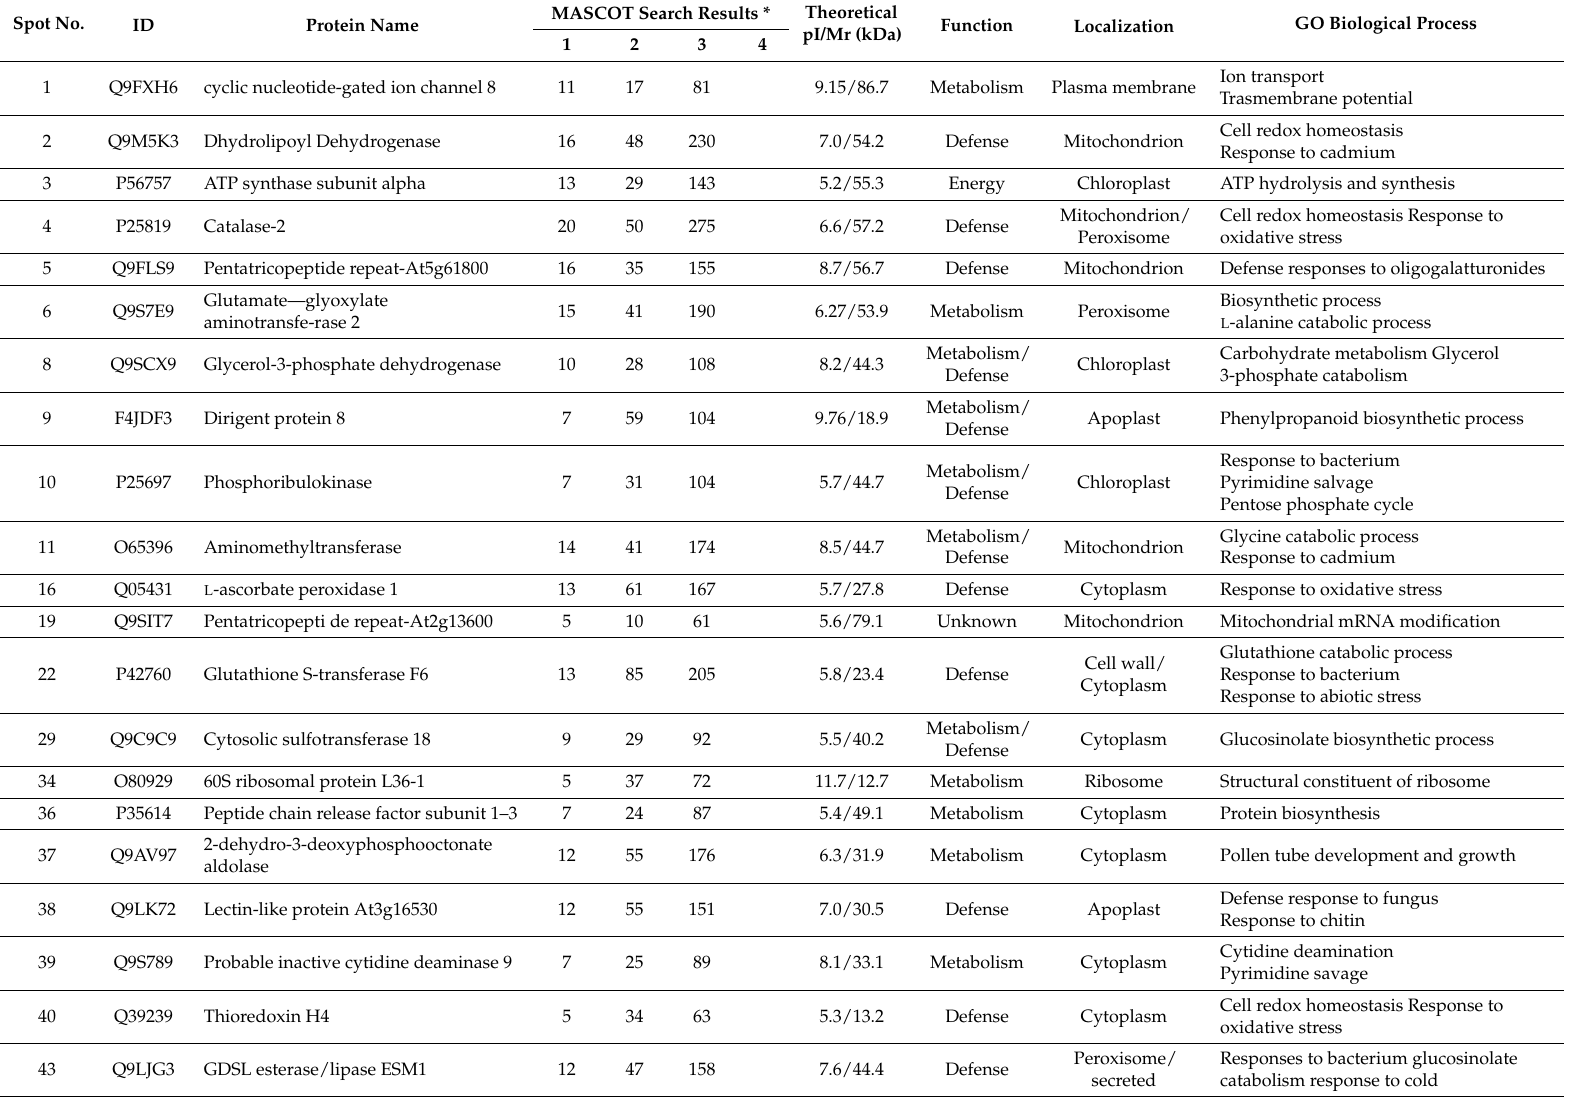
Table 2. Over-expressed proteins in CP-treated leaves after 2D electrophoresis and MALDI-ToF MS analysis. Spot